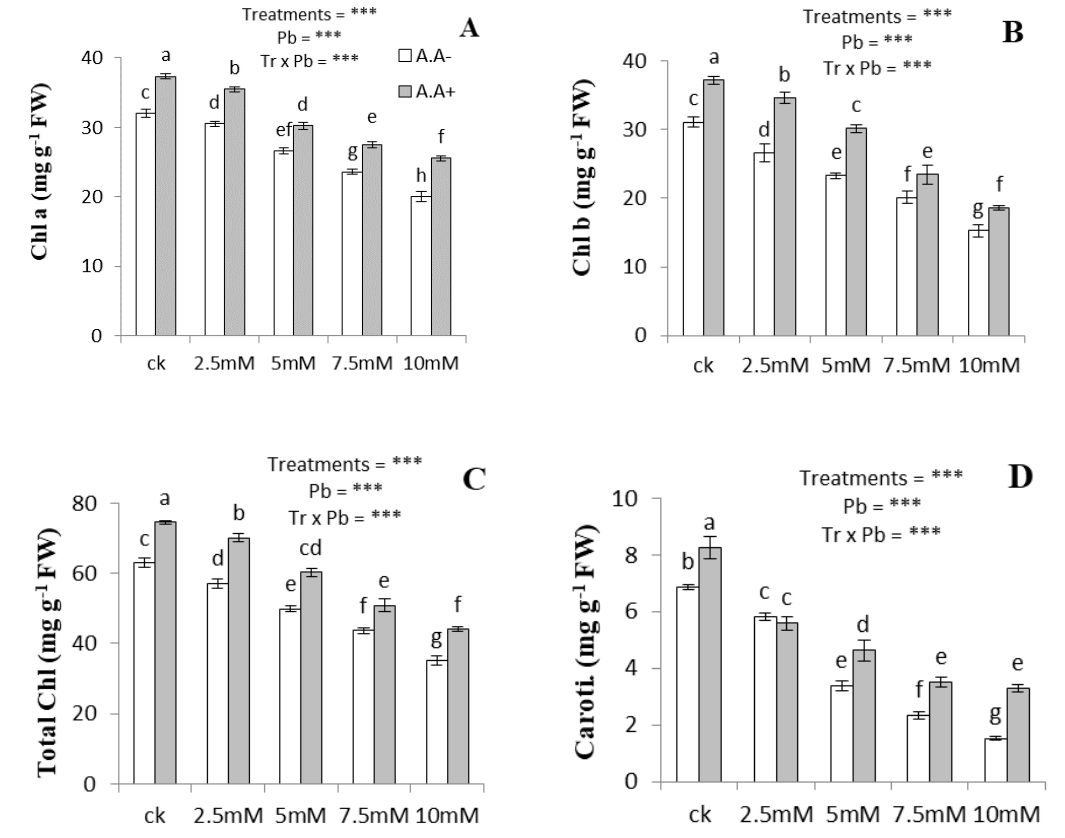
Figure 1. Effect of Pb and AA on chlorophyll a ( A ), chlorophyll b ( B ), total chlorophylls ( C ) and carotenoids ( D ) in A. bettzickiana grown in soil with increasing Pb (0, 2.5, 5, 7.5 and 10 mM) and AA concentrations (0 and 2.5 mM). Values are mean of three replicates ± S.D. Different lowercase letters indicate significant differences between treatments at p < 0.05; and *** indicate significance at the p < 0.01 level.